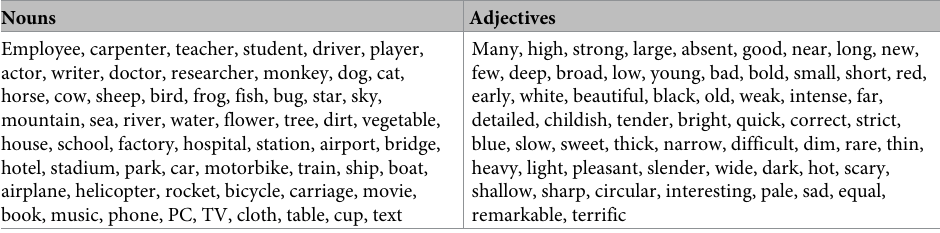
Many, high, strong, large, absent, good, near, long, new, few, deep, broad, low, young, bad, bold, small, short, red, early, white, beautiful, black, old, weak, intense, far, detailed, childish, tender, bright, quick, correct, strict, blue, slow, sweet, thick, narrow, difficult, dim, rare, thin, heavy, light, pleasant, slender, wide, dark, hot, scary, shallow, sharp, circular, interesting, pale, sad, equal, remarkable, terrific